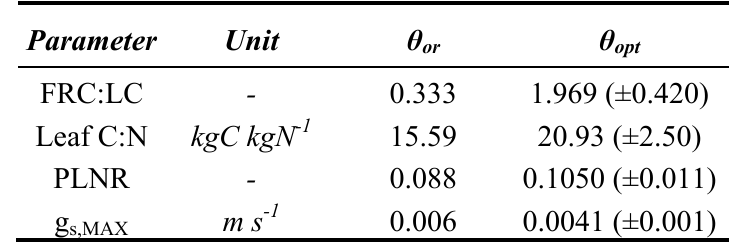
) and optimized ( θ ) parameters of the PROSAILH-BGC model. Table 2. Original ( θ or opt Standard errors of parameter estimates, calculated with the bootstrap algorithm, are shown in